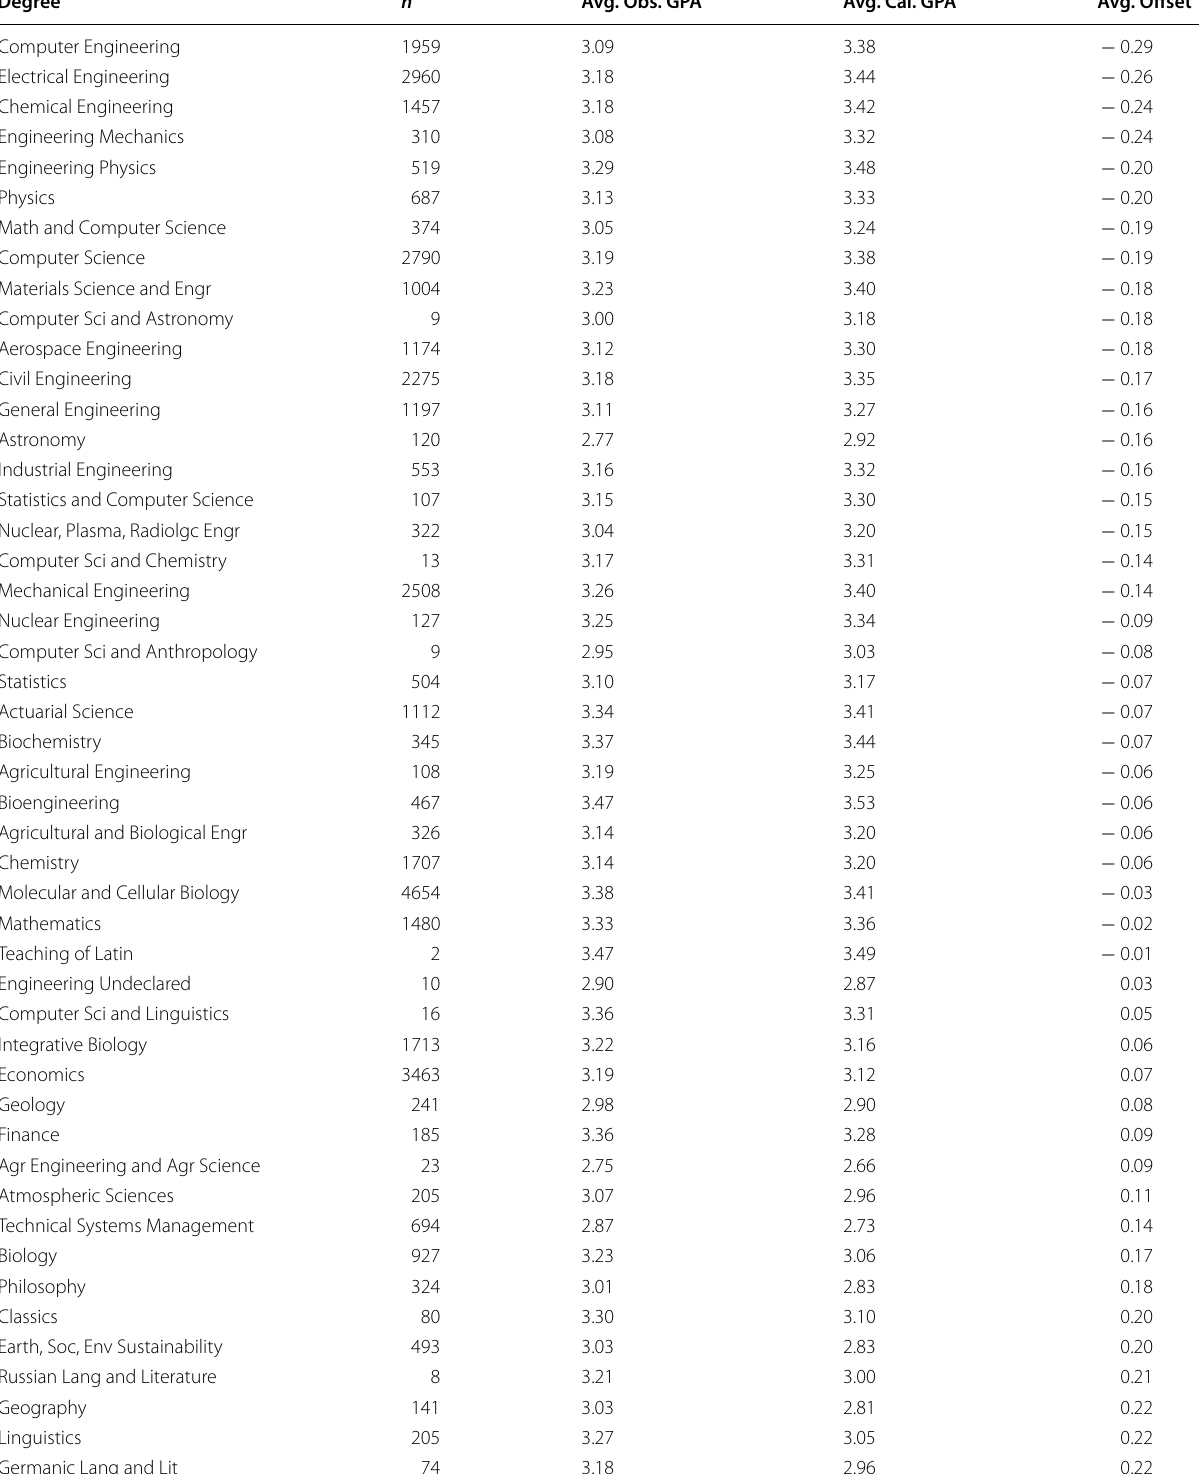
Table 1 Average grade offset of students in different majors, as measured by the difference in the average observed and calibrated GPAs of each major Degree n Avg. Obs. GPA Avg. Cal. GPA Avg.